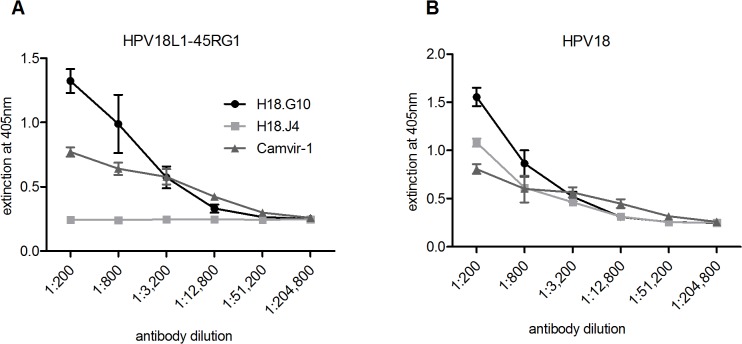
Characterization of chimeric HPV18L1–45RG1 by ELISA.Chimeric 18L1–45RG1 VLP (left) or wt HPV18L1 VLP (right) (50ng per well) were used as antigens and attached to 96 well plates under native conditions. ELISA was performed in triplicates with fourfold serial antibody endpoint dilutions ranging from 1:200–1:204,800 using HPV18-specific conformational-dependent neutralizing mAb H18.G10 and H18.J4, or non-neutralizing mAb Camvir-1 directed to a linear L1 epitope. Results indicate that RG1 epitope insertion into HPV18L1–45RG1 VLP disrupted (or sterically hindered) the recognition site of H18.J4, whereas the sites for H18.G10 and Camvir-1 remained intact. Data are shown as mean OD ± standard deviation (SD).